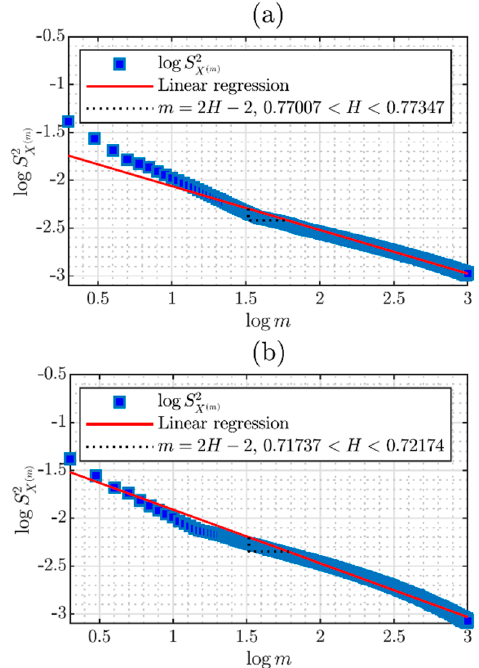
Figure 12. ( a ) VT diagram for a trace of monofractal synthesized data. ( b ) VT diagram for a trace of synthesized multifractal data.